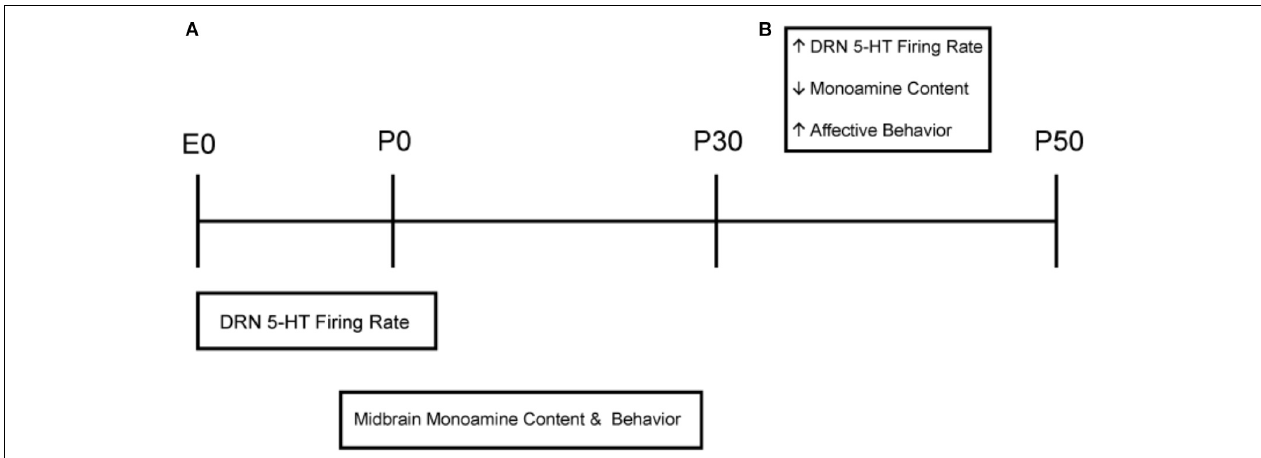
FIGURE 6 | Sensitive periods impacted by Long photoperiod exposures and age related changes throughout development. (A) Long photoperiods program DRN 5-HT neuronal firing primarily during prenatal development, whereas exposure to Short photoperiods in gestation may extend this sensitive period into the early postnatal period. In addition, Long photoperiod exposures have both pre and postnatal origins impacting midbrain serotonergic content and affective behaviors later in life. (B) Age effects independent of photoperiod were observed in which adolescent (P30) mice demonstrated increased 5-HT neuronal firing rate in the DRN, no difference in 5-HT or 5-HIAA midbrain content and elevated levels of anxiety and depressive-like behavior compared to adult (P50)